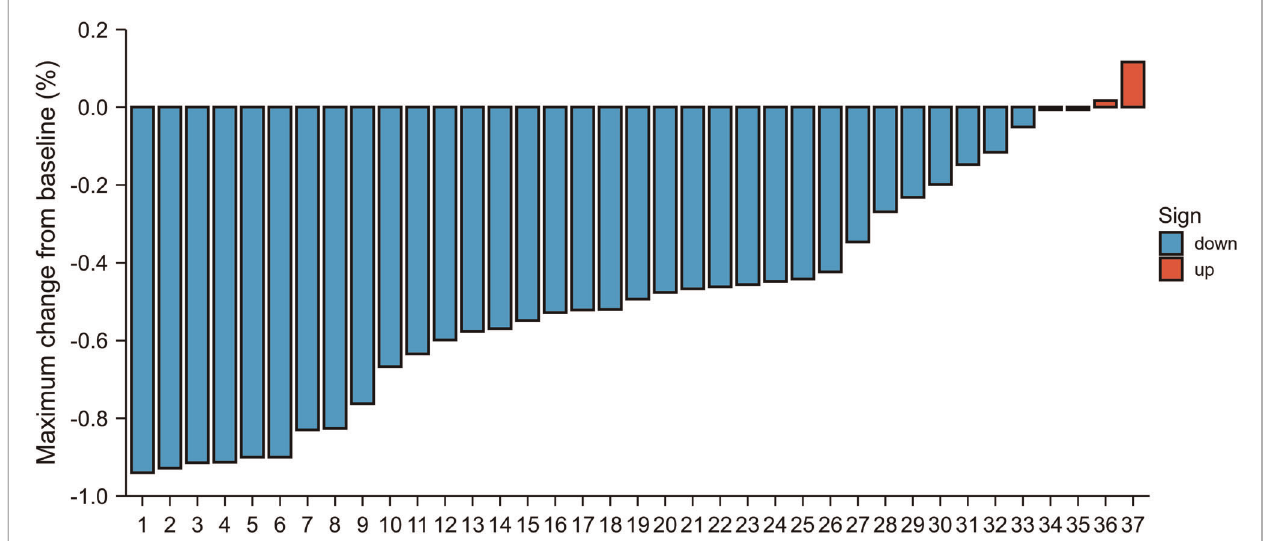
FIGURE 1 | The best change in the longest primary lesion diameters from